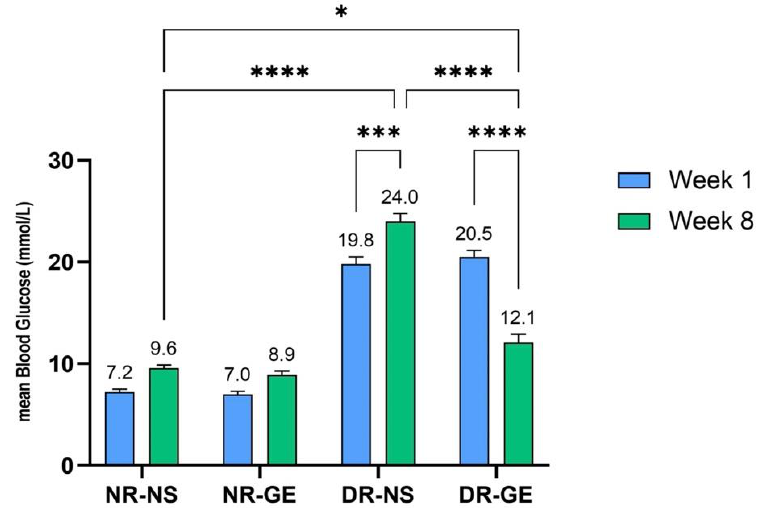
Figure 2. Changes in fasting blood glucose (mmol/L) for all rat groups after 1 and 8 weeks of GE treatment. *: p ≤ 0.05, ***: p ≤ 0.01, ****: p ≤ 0.001.